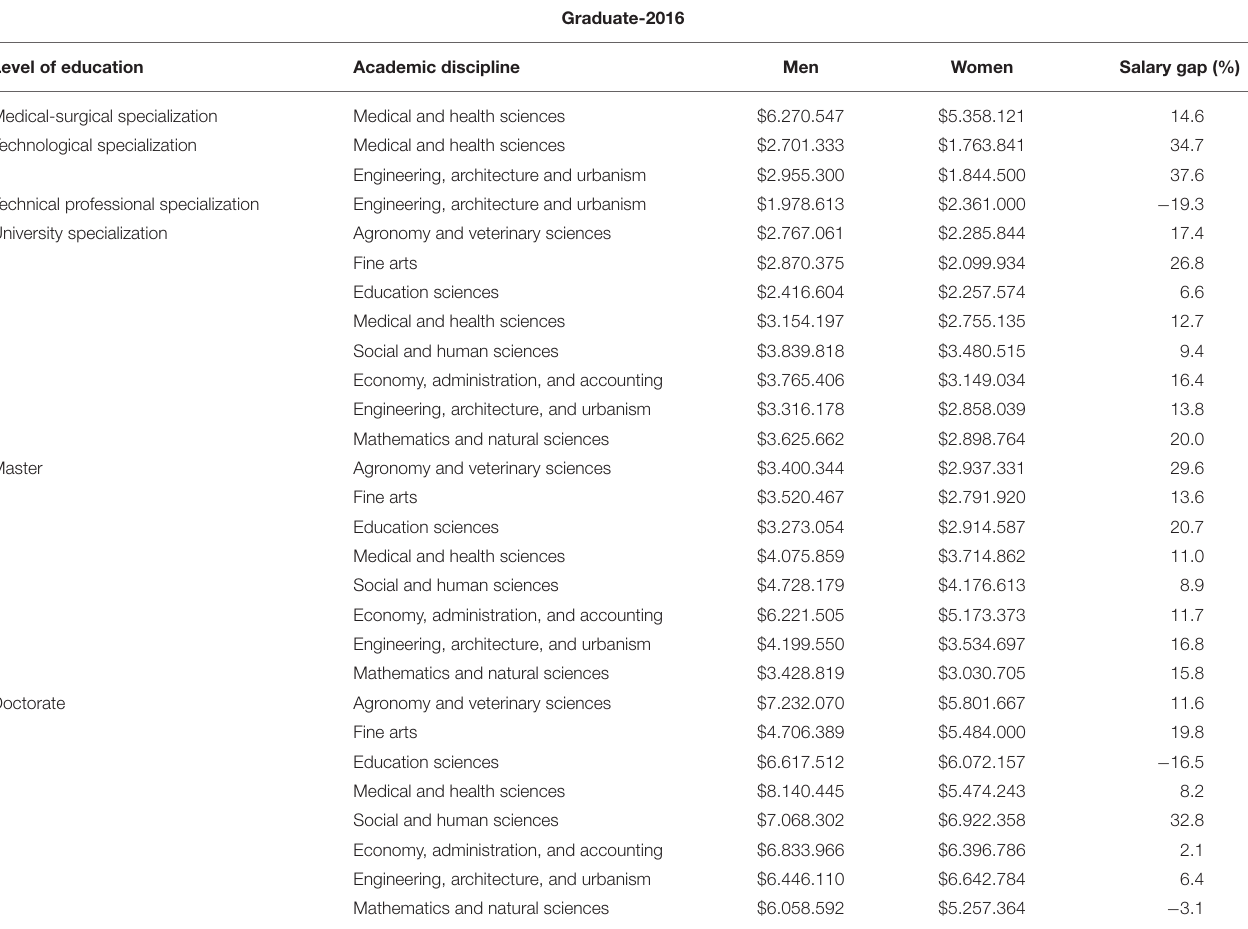
TABLE 4 | Salaries in 2016 of graduates from postgraduate programs in 2015 at higher education institutions in Colombia, divided by gender and academic